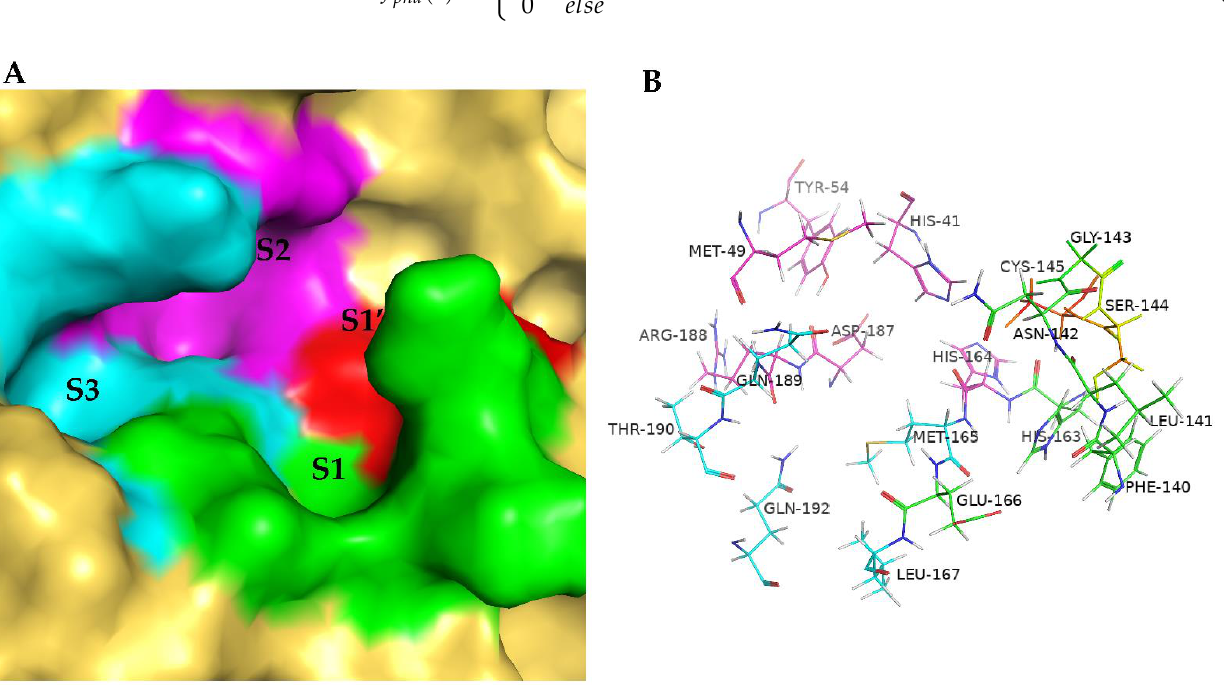
Figure 10. Binding site of SARS-CoV-2 3CL pro . ( A ) Surfaces of subsites that complement the substrate-binding pocket that are labeled as S1 (green), S1’ (red), S2 (magenta), and S3 (cyan). ( B ) Key residues of the binding site that are presented as green, red, magenta, and cyan lines (S1, S1’, S2, and S3). Images of the binding site were generated by using PyMol (http://www.pymol.org/).